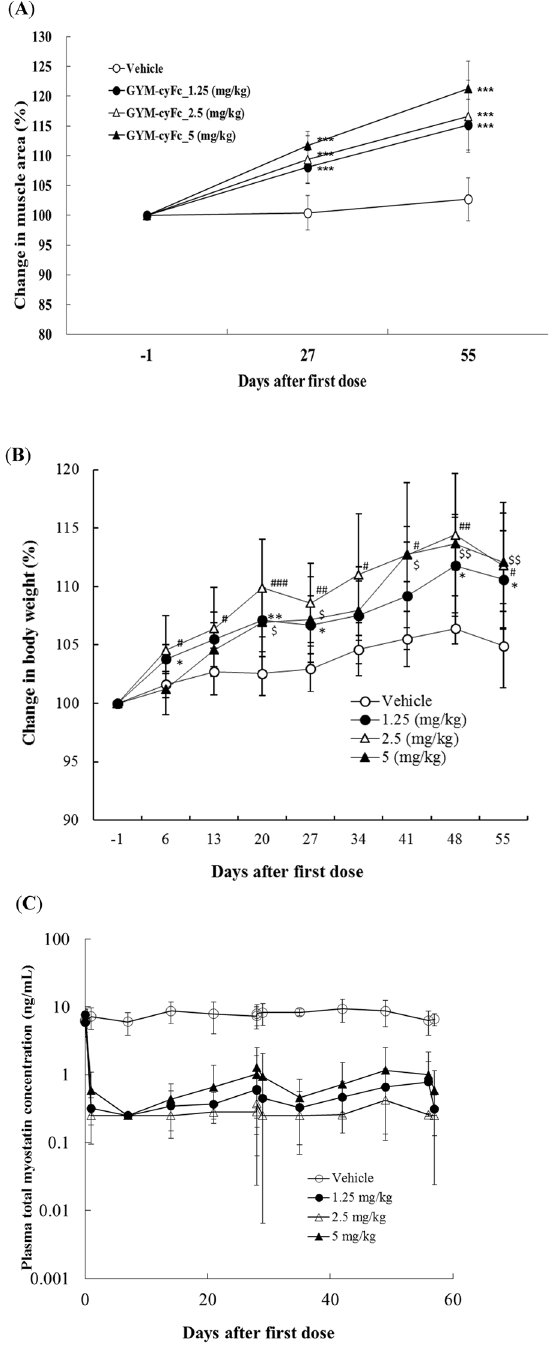
Figure 5. The monkey GYM329 surrogate antibody, GYM-cyFc, increases muscle area and bodyweight, and reduces total myostatin levels in cynomolgus monkeys. ( A ) Muscle section area determined by MRI are presented as the sum of the area of the quadriceps femoris, brachialis, and elector spinae on days − 1 (Pre), 27 (4 weeks), and 55 (8 weeks) from the administration (i.v.) of the first dose of GYM-cyFc. GYM-cyFc was administered every 4 weeks for 2 months. From the results of anti-drug antibody (ADA) and pharmacokinetic analyses, ADA-positive animals were excluded (vehicle group: n = 6; 1.25 mg/kg dose: n = 9; 2.5 mg/kg dose: n = 6; and 5 mg/kg dose: n = 5). Data represent mean ± SD. *** P < 0.0005, Williams’ test for multiple comparisons to the vehicle group. ( B ) The rates of increase in bodyweight relative to baseline after the 1 st administration of GYM-cyFc into cynomolgus monkeys. Data represent mean ± SD. * /#/$ P < 0.025, ** /##/$$ P < 0.005, *** /###/$$$ P < 0.0005, Williams test for multiple comparisons to the vehicle group (*: 1.25 mg/kg; # : 2.5 mg/kg; and $ : 5 mg/kg). ( C ) Plasma concentration–time curve of total myostatin. Total myostatin is the C-terminal domain of myostatin including both antibody-bound and unbound, or other protein-bound myostatin forms. Values under 0.25 ng/mL were considered to be below the limit of quantification (BLQ). Data represent mean ±